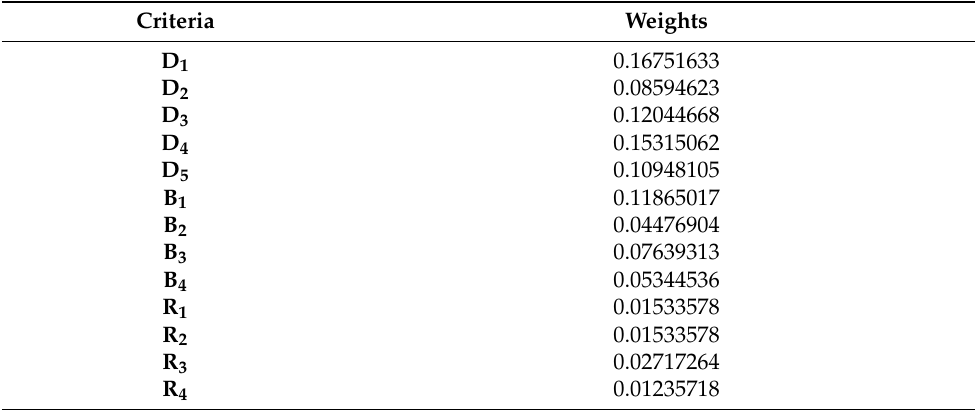
Table 6. The final weights on the generated OWA decision-maker